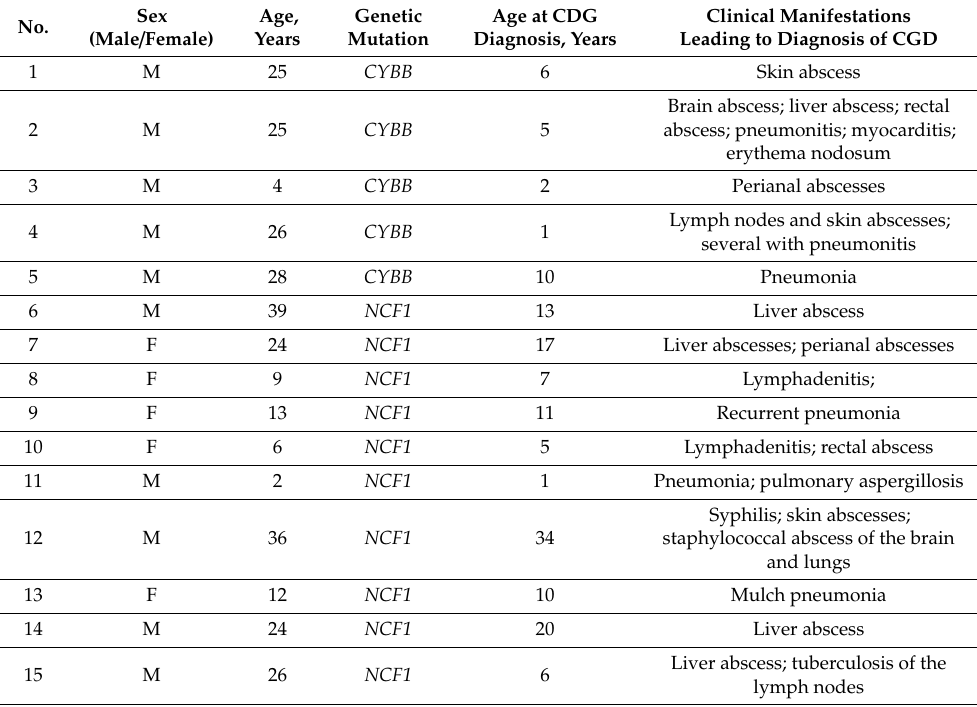
Table 2. Basic clinical data for patients with chronic granulomatous disease